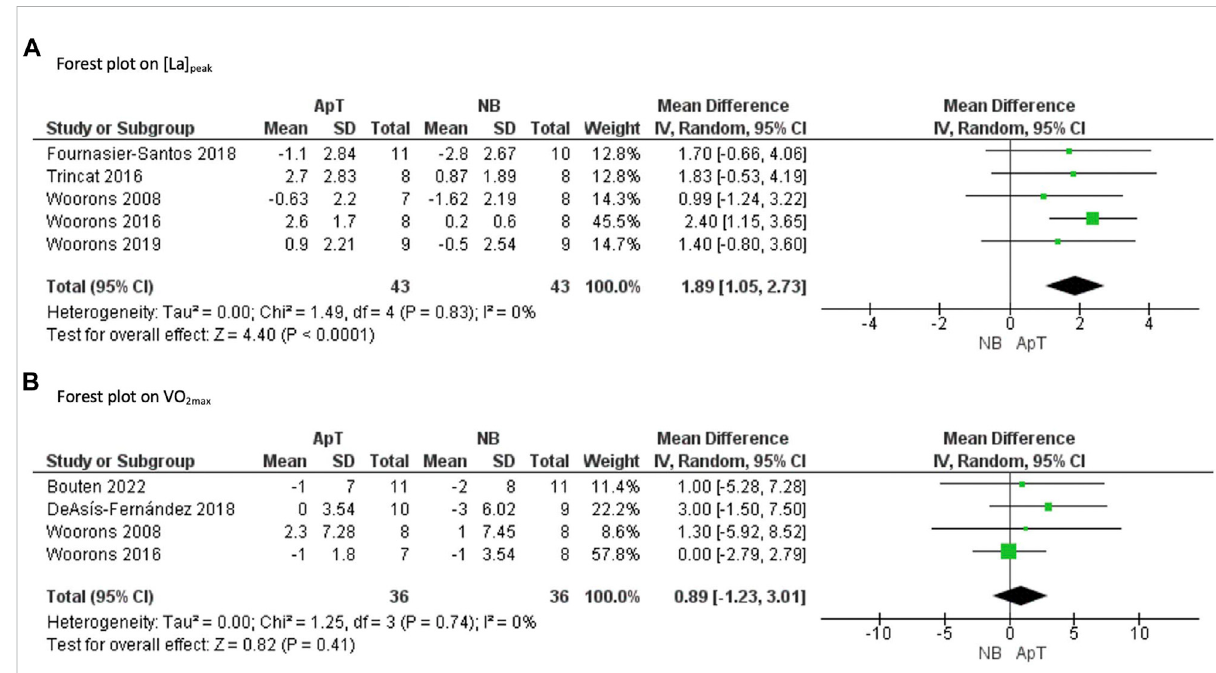
FIGURE 2 Forest plot of the effects of apnoea training (ApT) and Normal Breathing (NB) on [La] peak peak blood lactate concentration (A) and VO 2max maximal aerobic capacity (B) . CI con fi dence interval, SD standard deviation, IV weighted mean